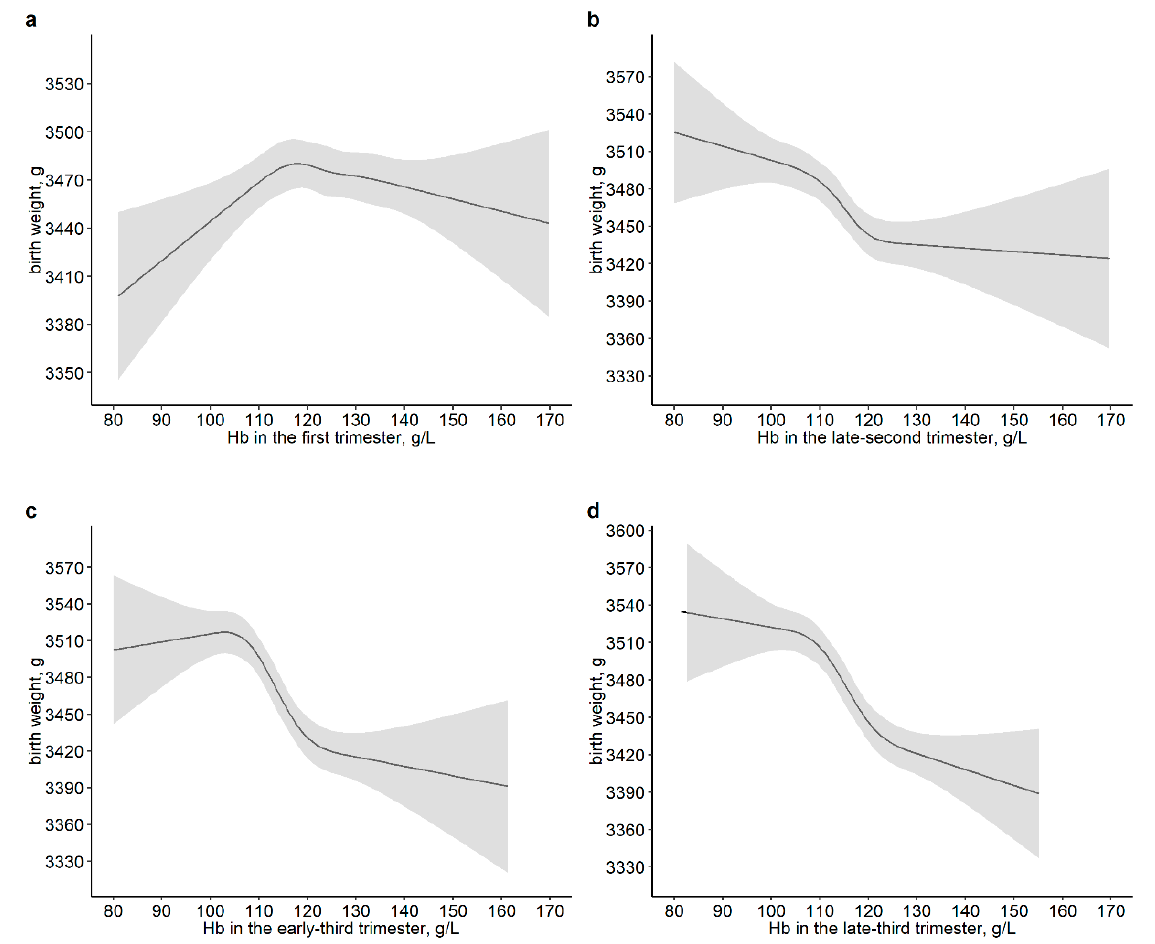
Figure 2. Dose–response associations of maternal hemoglobin in the first trimester ( a ), in the late-second trimester ( b ), in the early-third trimester ( c ) and in the late-third trimester ( d ) with neonatal birth weight. The p -values for overall associations were <0.001. The p -values for non-linear associations were 0.011 ( a ), 0.009 ( b ), <0.001 ( c ) and <0.001 ( d ), respectively. Models were adjusted for maternal age, education, parity, gestational age of hemoglobin measurement, neonatal gender, gestational age at delivery, mode of delivery, maternal BMI in the first trimester and weight gain during pregnancy.